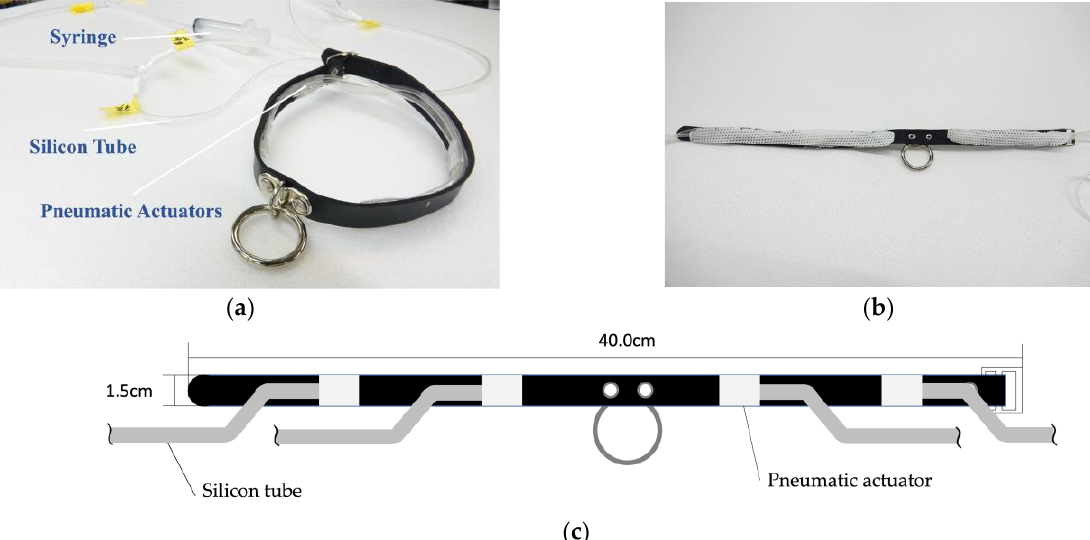
Figure 4. The prototype and the schematic of the haptic presentation device. ( a ) Prototype of the haptic device. ( b ) The actuators and the tubes were concealed by a cloth. ( c ) Blueprint of the proposed device.